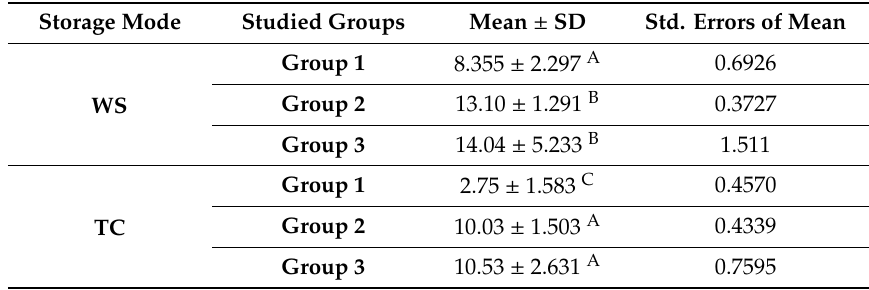
Table 1. Mean shear bond strengths (MPa) and standard deviations for the experimental groups with analytical results.